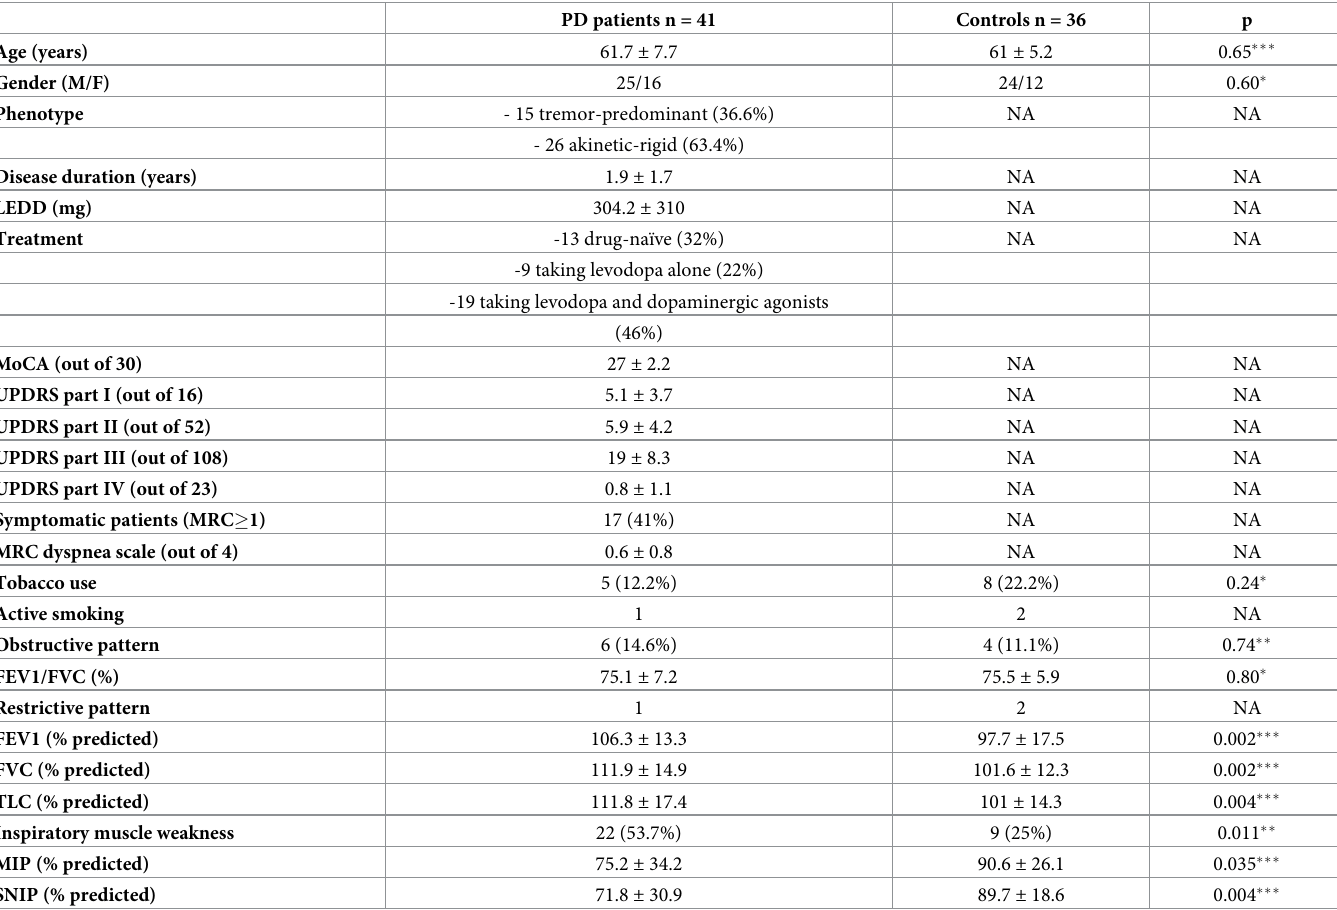
Table 1. A comparison between PD patients and healthy